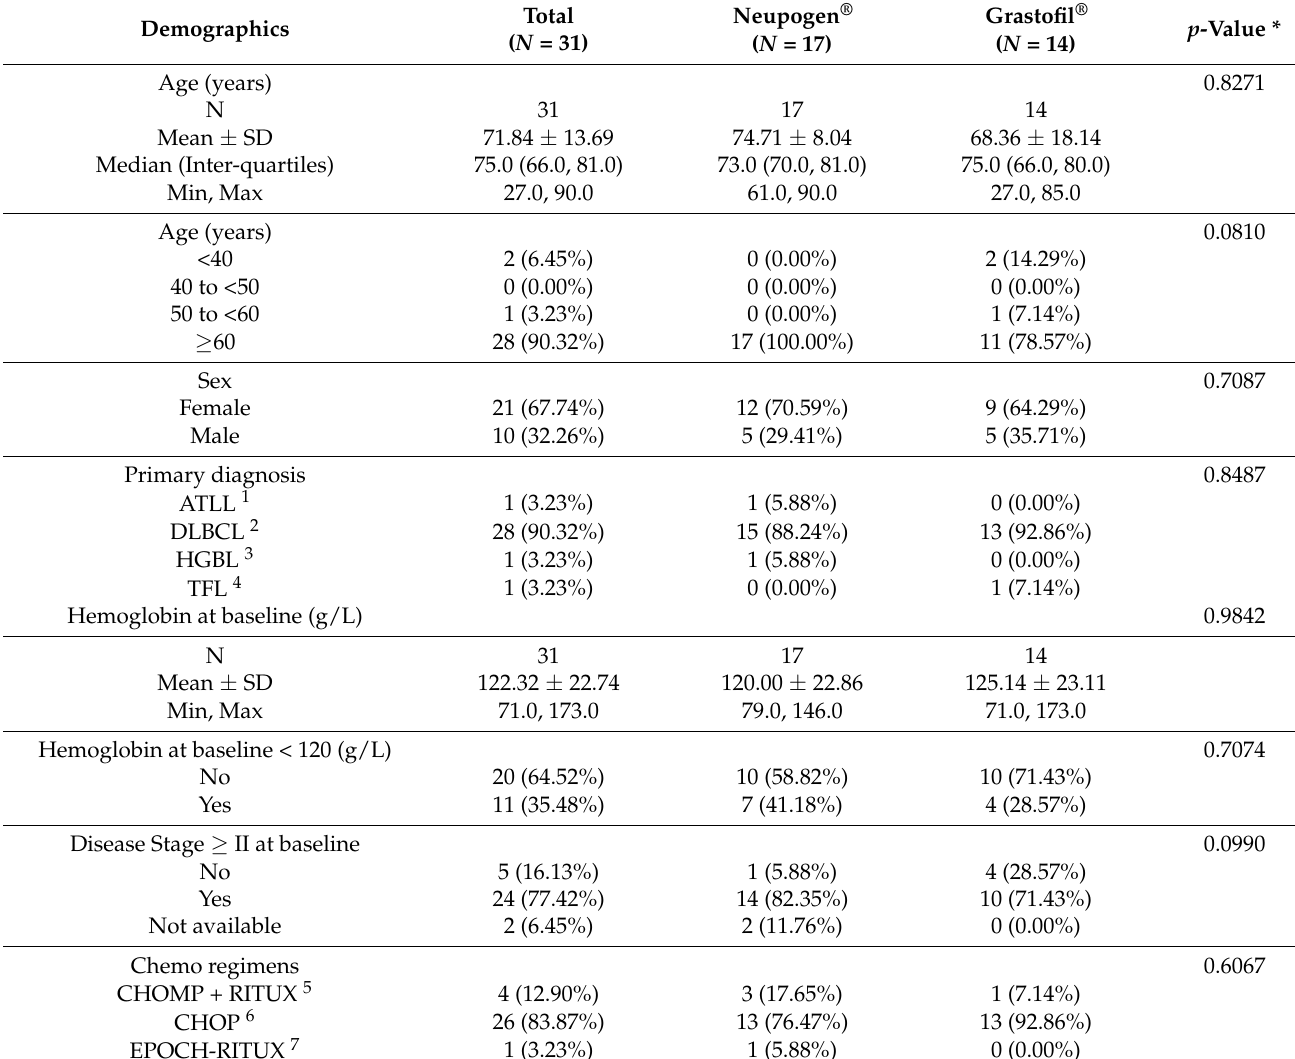
Table 3. Demographics in Lymphoma Patients